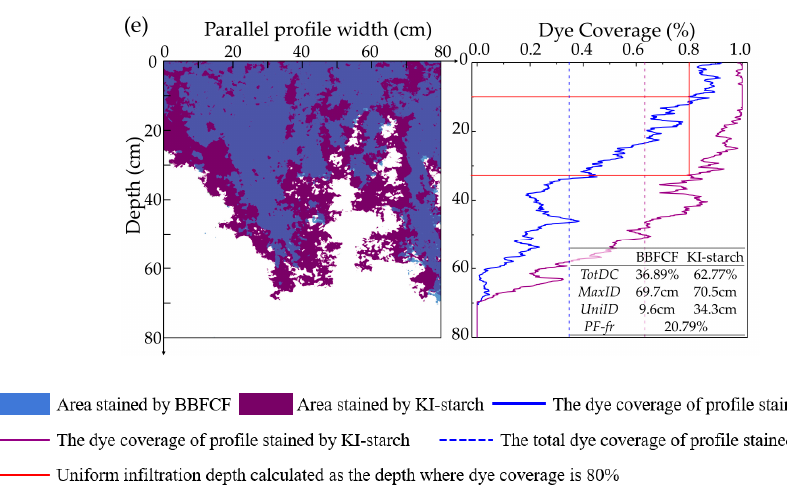
Figure 5. Examples of representative stained sections of the five experimental plots ( a ) bottom–, ( b ) lower–, ( c ) mid–, ( d ) upper–, and ( e ) top–slope, showing their corresponding change of dye coverage with depth. The parameters extracted from the left–hand stained image that were used to quantify the degree of preferential flow are showed in the table in the right–hand chart. TotDC : total dye coverage (%); MaxID : maximum infiltration depth (cm); UniID : uniform infiltration depth (cm); PF–fr : preferential flow fraction (%).